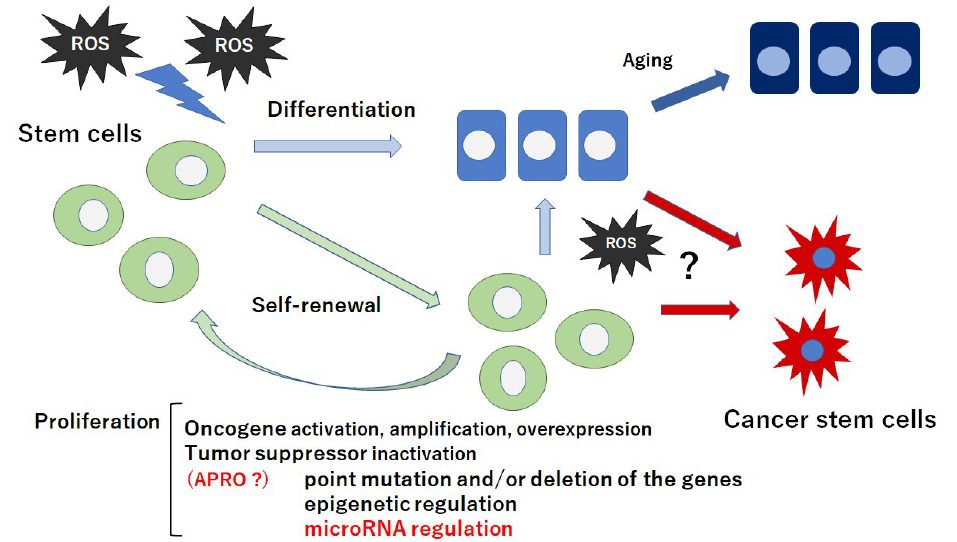
Figure 1. Schematic representation of stem cells self-renewal, proliferation, and differentiation. Stem cells and/or cancer stem cells are capable of maintaining the stem cells population through appropriate self-renewal and proliferation. Quiescent and/or self-renewing stem cells exhibit low ROS levels probably due to their robust antioxidant ability. Intermediate levels of ROS may prime stem cells for differentiation and/or cancer stem cell-formation. Tumor suppressor inactivation by microRNA-regulation could lead to the proliferation of stem cells and/or cancer stem cells. Note that some critical pathways have been omitted for clarity. ?: the phenomena have not yet been confirmed at